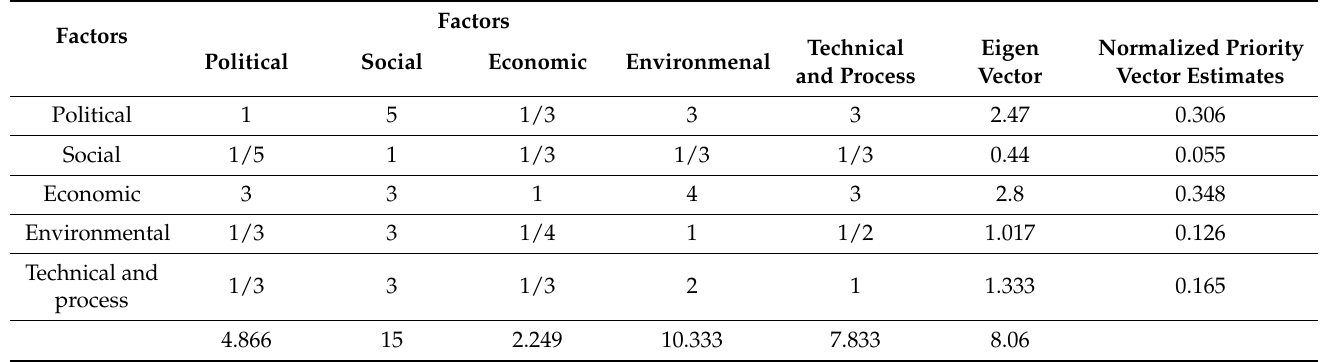
Table 2. Pairwise Comparison Matrix of Factors Affecting the Functioning and Development of the Iraqi Gas